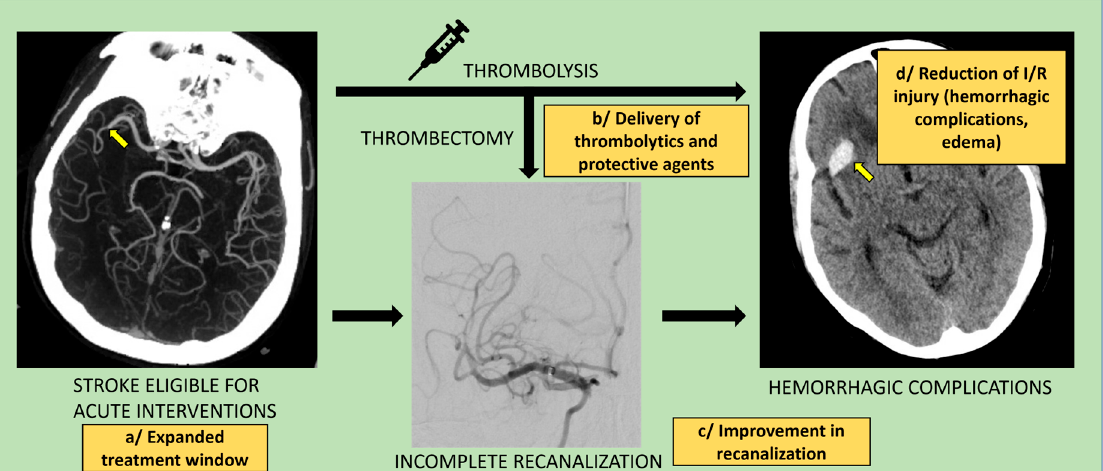
Figure 4. Main objectives for clinical application of nanoparticles in acute ischemic stroke. Nanoparticle-based approaches could improve acute ischemic stroke treatment by: expanding the treatment window eligibility (safer thrombolytics) ( a ), improving delivery modes for thrombolytics (increased affinity for thrombus, longer half-life) and enabling delivery of neuro/vaso-protective agents ( b ), enhancing recanalization rates with pharmacological, physical, or chemical function ( c ), and reducing ischemia/reperfusion (I/R) injury with subsequent decrease in infarct site complications (hemorrhagic transformation, tissue edema) ( d